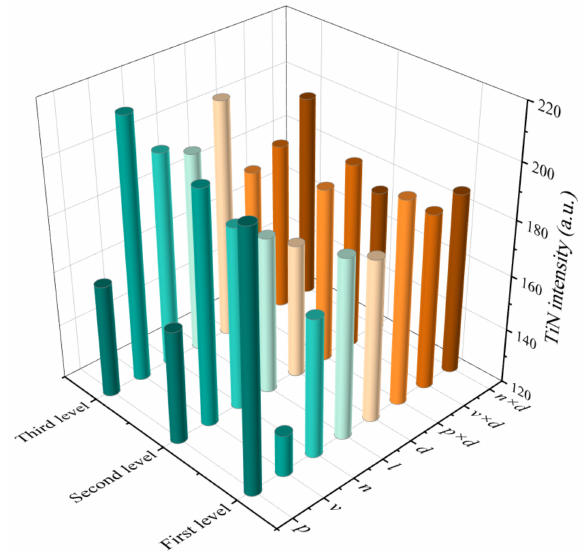
Figure 6. TiN phase range analysis results.